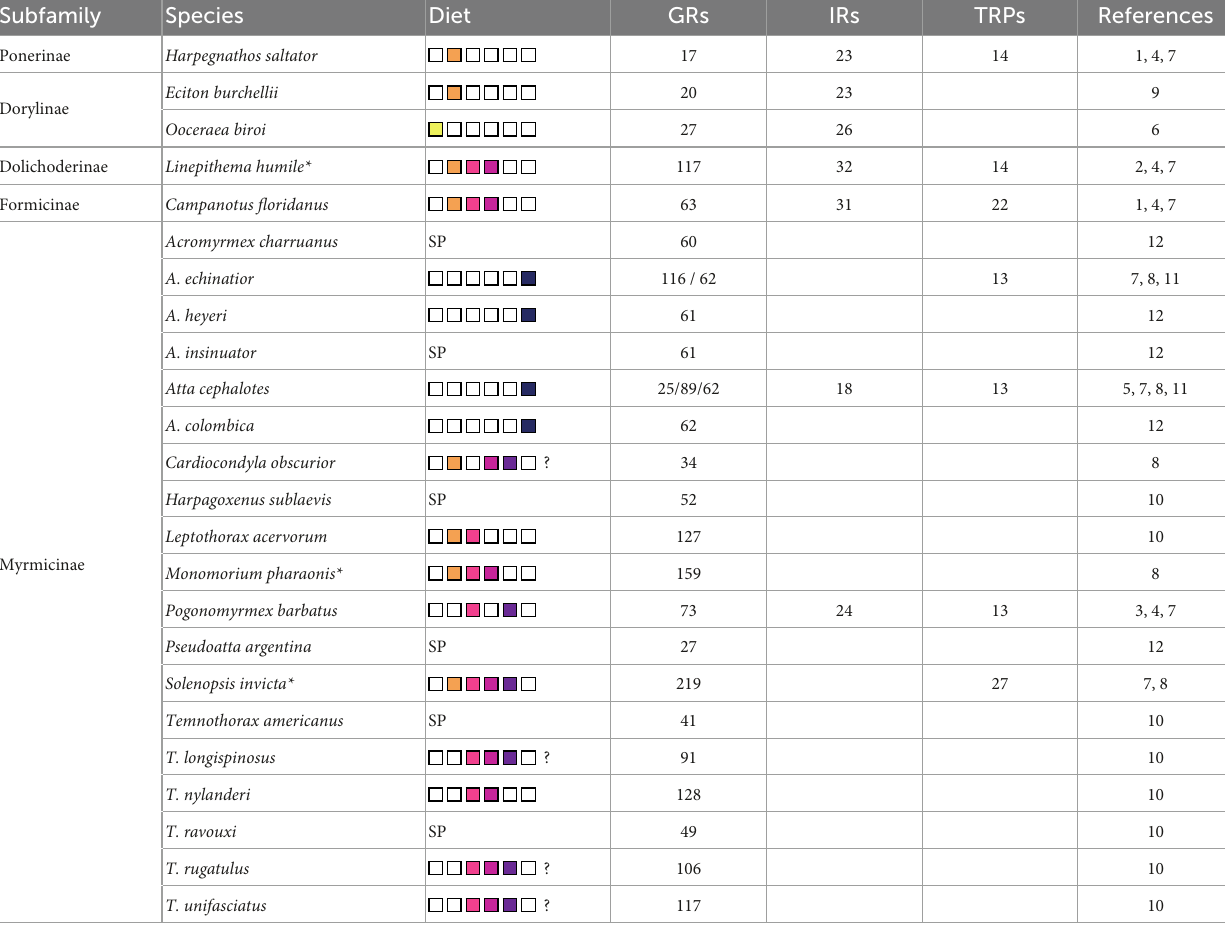
TABLE 1 Reported GR number, IR number, TRP channel number, and diet information of species with annotated genomes. Subfamily Species Diet GRs IRs TRPs